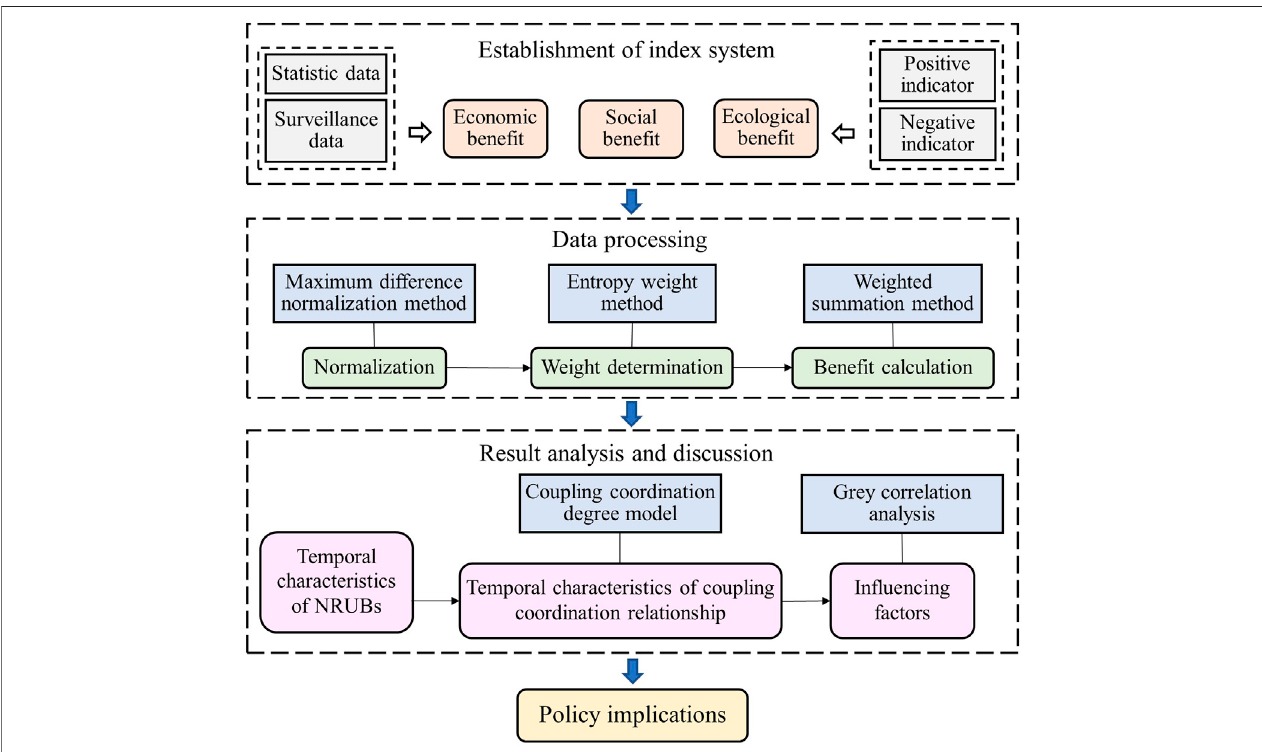
FIGURE 2 | Research framework.